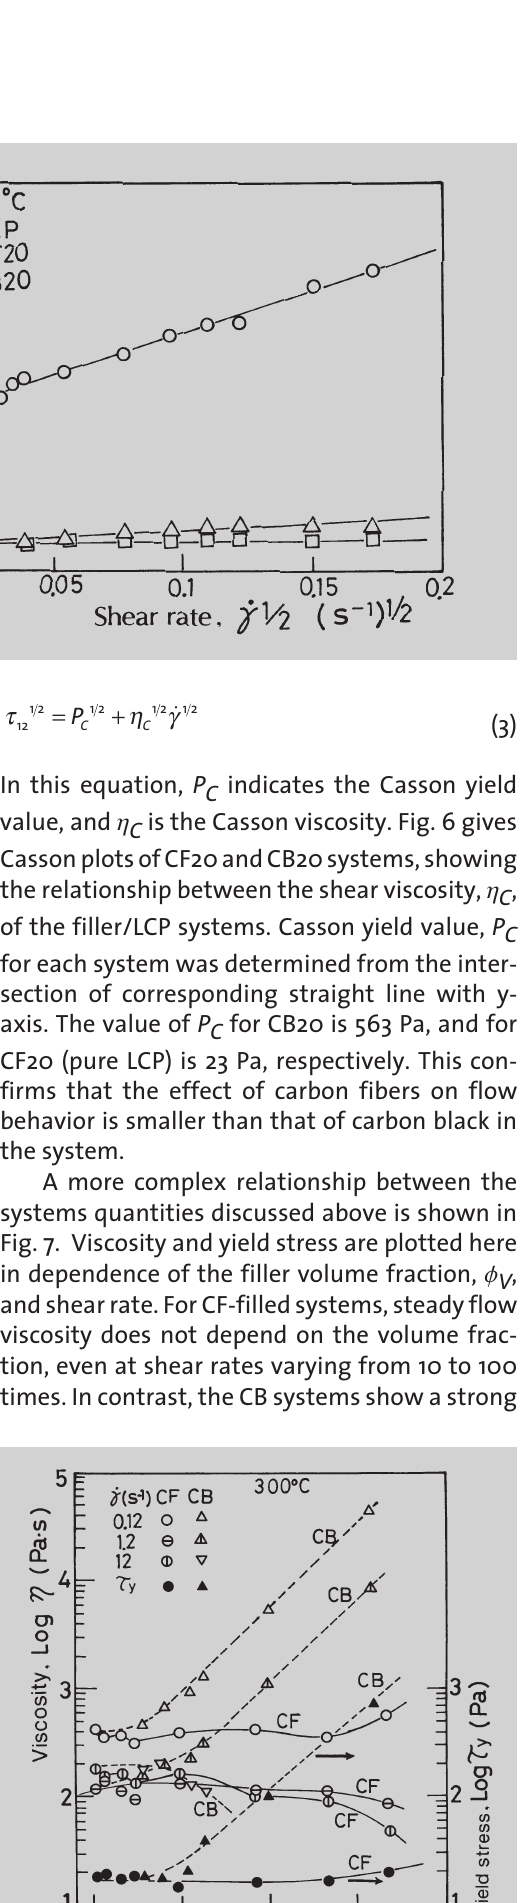
Figure 7: Viscosity, h , and yield stress t 12, of CF and CB filled LCP as a function of the filler volume fraction, f v, at various shear